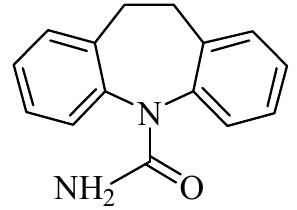
Figure 1. The structure of carbamazepine.